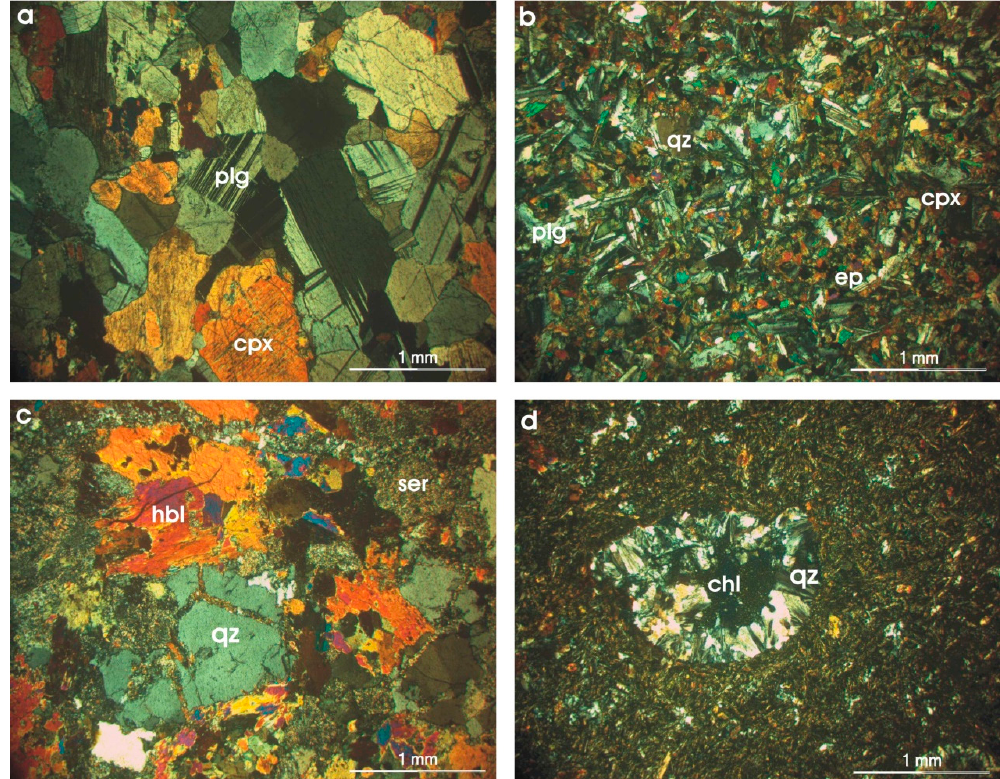
Figure 4. Photomicrographs of representative mafic aggregate rocks (XPL): ( a ) granular subhedral texture in a gabbro (sample KIL.5), ( b ) subophitic texture in a diabase with crystals of quartz and epidote (sample KIL.3), ( c ) granular with subhedral to euhedral intensely altered plagioclase as well as hornblende and quartz in a diorite (sample BE.77), and ( d ) porphyritic and microlitic textures in basalt with amygdules containing chlorite surrounded by quartz (sample ED.66A). Abbreviations: